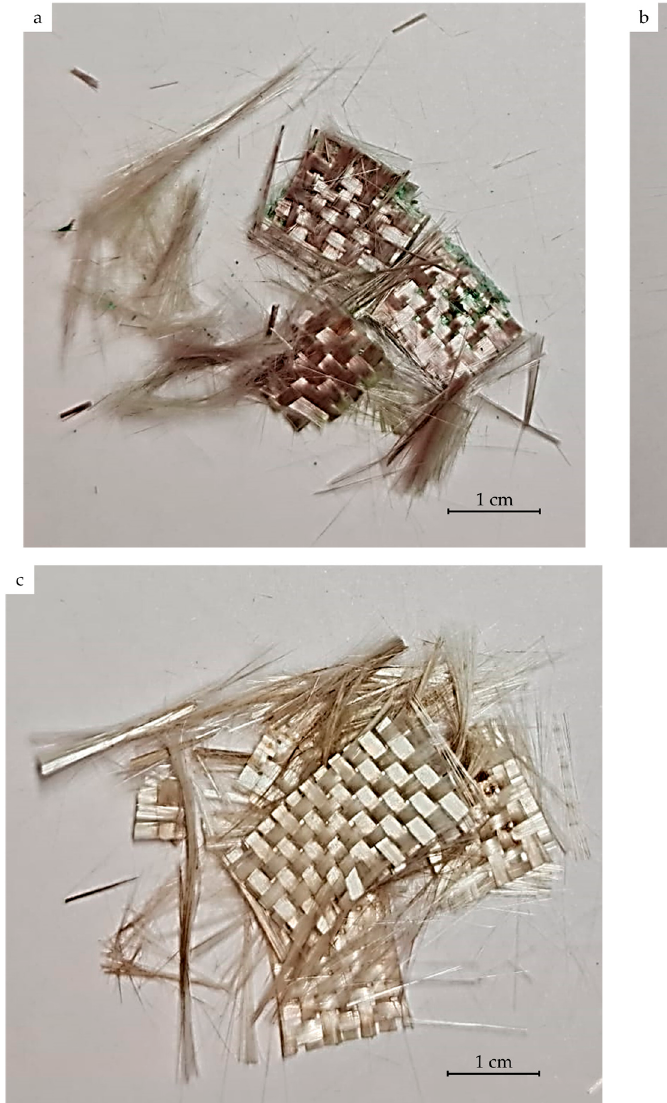
Figure 9. Photos of recovered fiberglass samples treated in ethanol solution with ( a ) CuCl 2 ; ( b ) (2,3,5- TPhTz) 2 [CuCl 4 ]; ( c ) Table 2. Tensile strength of the recovered fi berglass (Table S1).